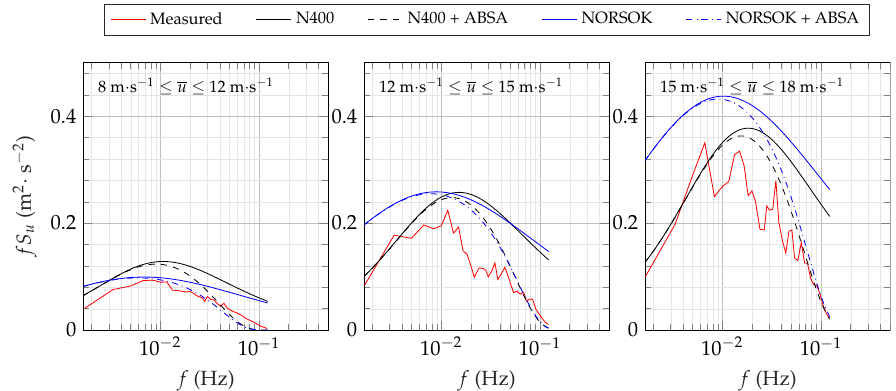
Figure 10. Power spectral density estimate of the along-wind velocity component recorded using both data recorded by LW2 and LE from the 07-06-2016 to 22-06-2016 (N-S configuration), using z 0 =